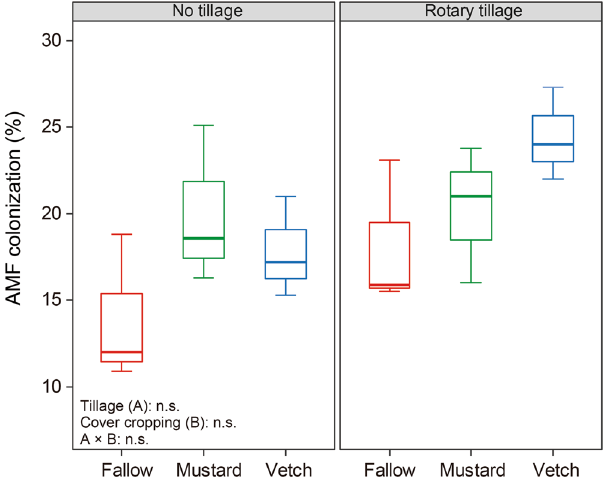
Figure 1. Influence of cover crops and tillage management on the colonization of arbuscular mycorrhizal fungi (AMF) in maize roots at the eight fully emerged leaves stage. Horizontal bold lines explain the median number; vertical lines explain minimum and maximum numbers of the plots and box margins ± standard errors. n.s.